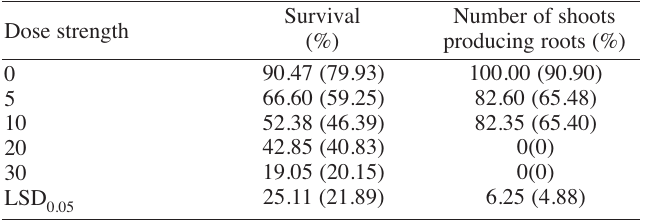
Figures within parentheses are arc sine transformed